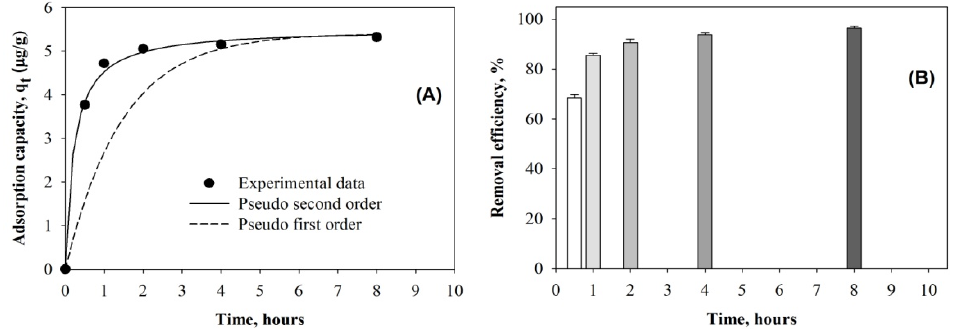
Figure 3. Kinetic study of arsenic adsorption onto FeOOH coated sand. ( A ) Adsorption capacity; ( B ) removal of As(III) by FeOOH coated sand.